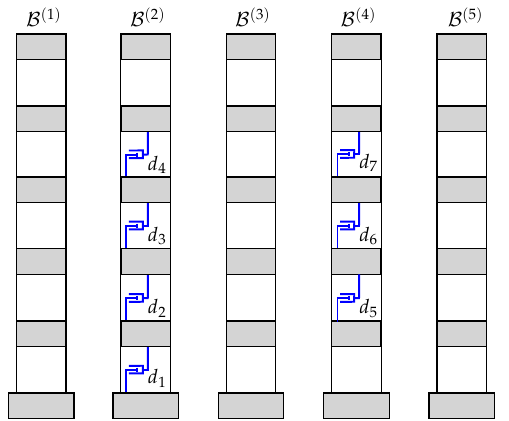
Figure 12. Fully unlinked damping configuration DC4 obtained by suppressing the interbuilding dampers in the linked configuration DC2.